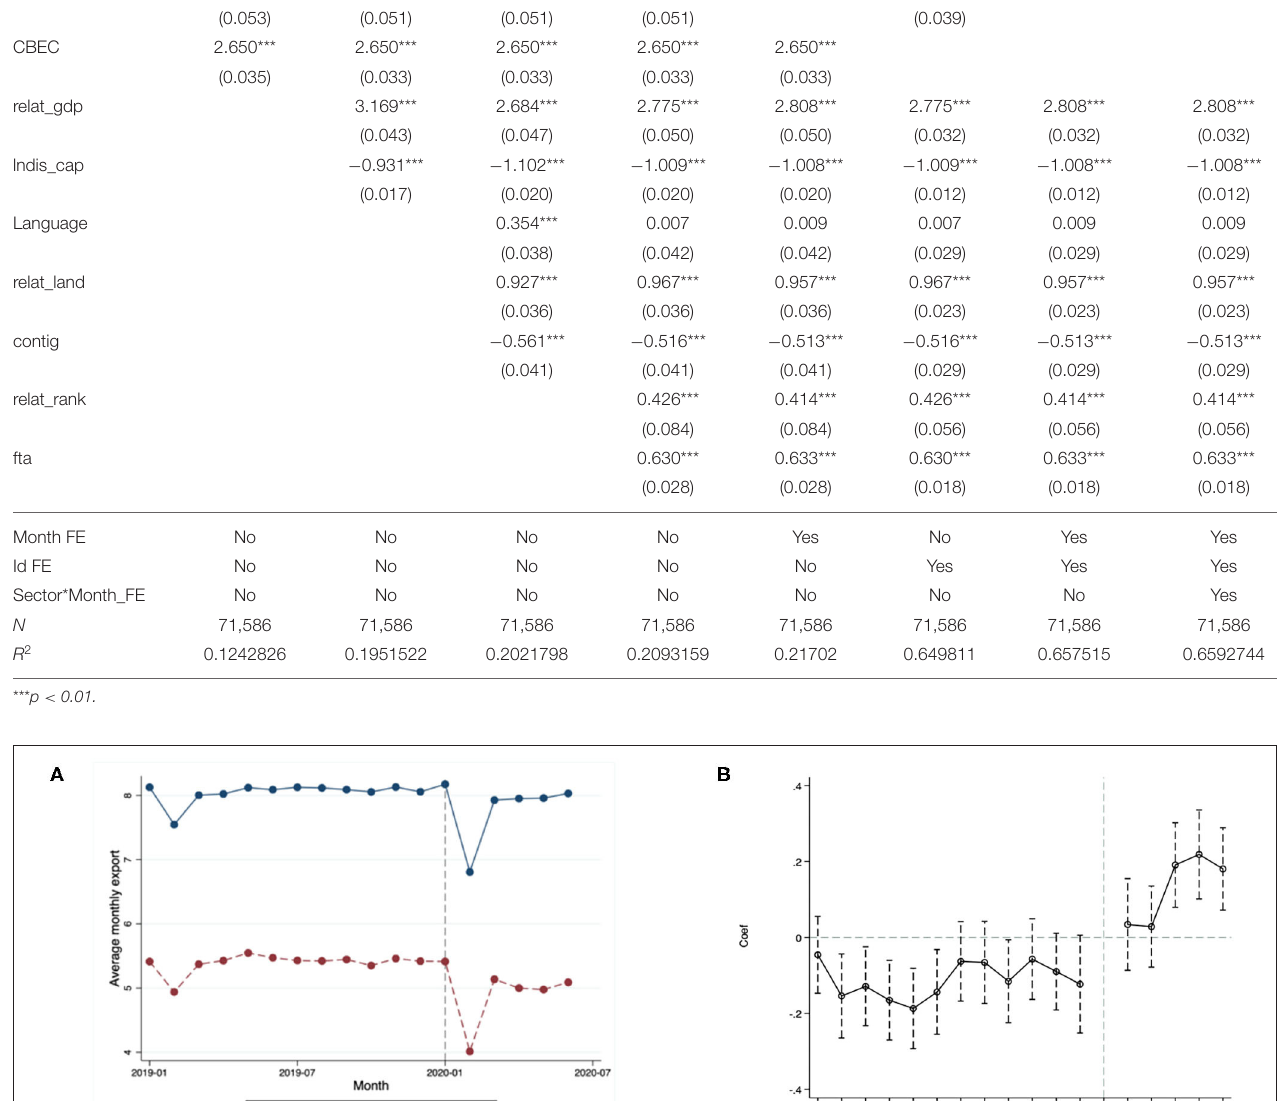
pandemic. Each circle represents the regression coefficient of the interaction term. The vertical dotted line crossing each circle represents the 95% confidence interval of the coefficient. For the purpose of testing the parallel trends of the samples, the